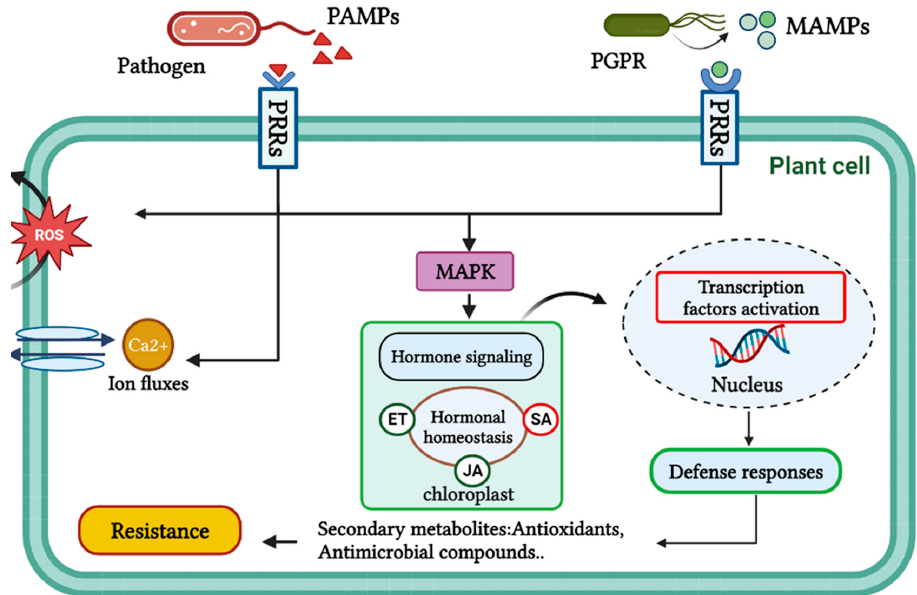
Figure 6. Schematic representation showing the activation processes of plant defense responses.